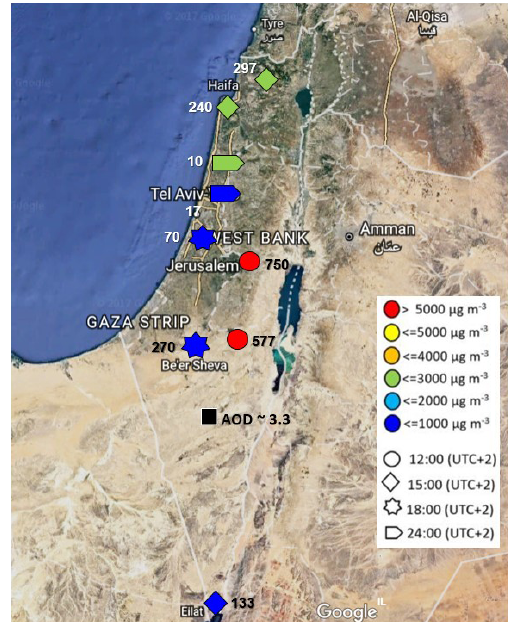
Figure 19. A map of PM 10 maximum hourly concentrations from nine sites measured on 8 September 2015 at 10:00UTC (midday). The map includes indications of the time of measurement (symbol shape), concentration range (symbol color), height of measurement site (numbers on map) and AOD from the AERONET Sde Boker